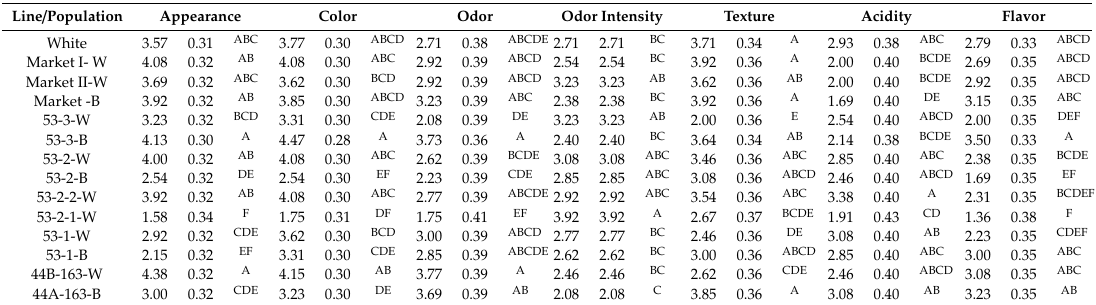
Different letters indicate significant differences at p < 0.05.